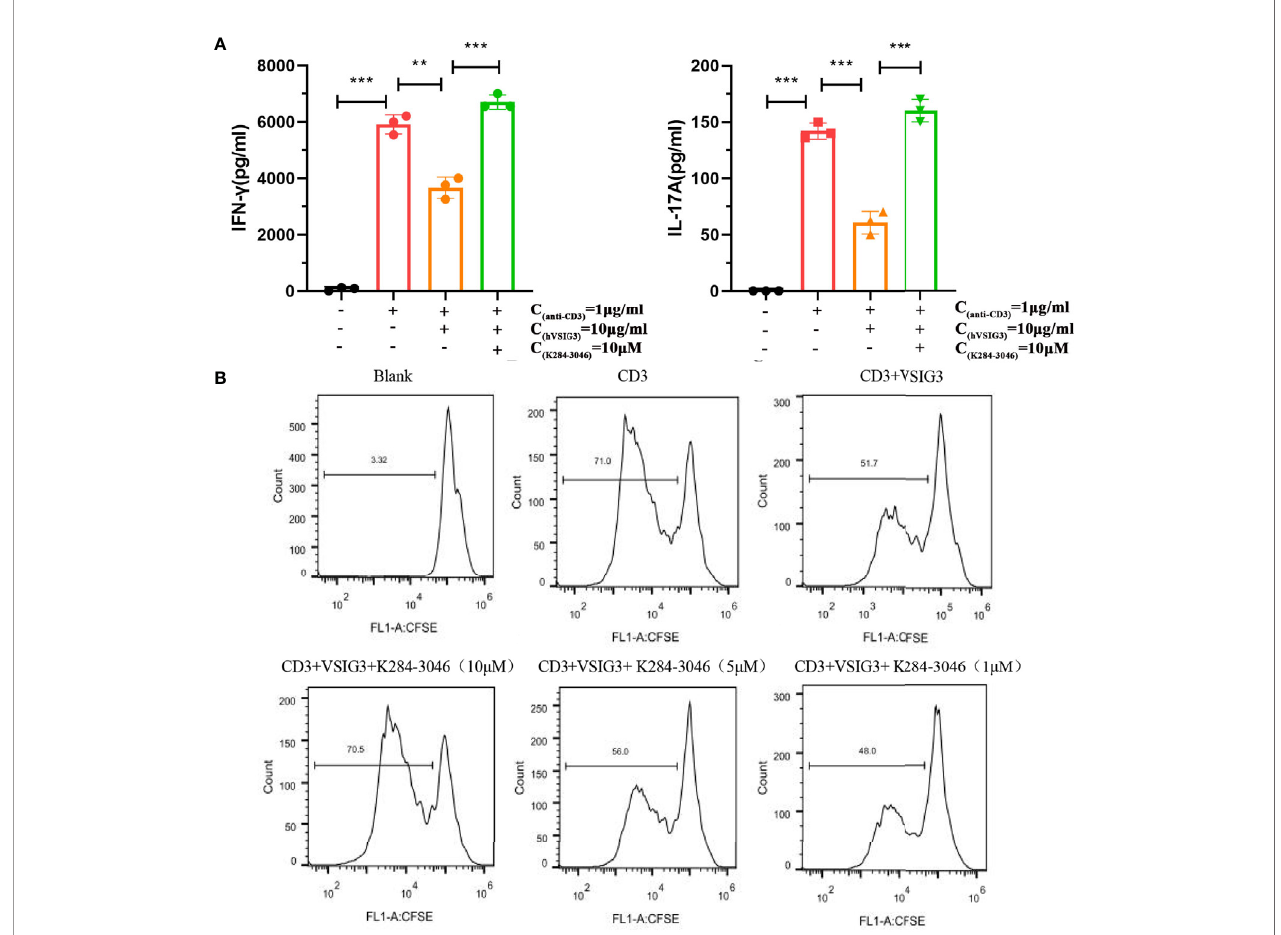
FIGURE 5 | K284-3046 blunted the inhibitory effect of VSIG3 on activated PBMCs and improved the inhibitory effect of VSIG3 on the proliferation of PBMCs. (A) A total of 1×10 5 PBMCs were incubated with an immobilized anti-human CD3 antibody (1 m g/mL) and human VSIG3 at 10 m g/mL, and compound K204-3046 was added as indicated. The levels of IFN- g and IL-17 in the cell culture supernatants were measured at 48 h using ELISA kits. ns: not signi fi cant, **p<0.01 and ***p<0.001 vs. control. (B) A total of 1×10 5 CFSE-labeled PBMCs were stimulated with plate-bound anti-human CD3 (1 m g/mL) together with co-absorbed human VSIG3 protein at 10 m g/mL, and compound K204-3046 was added at 10 m M. The proliferation levels of PBMCs were measured. Representative results from three independent experiments are